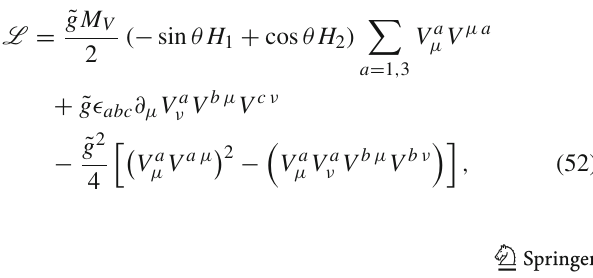
Fig. 16 Model points (red), in the [ M χ ible Higgs rate BR ( H → inv ) < 11% and complying with constraints from DM phenomenology. The model points in green are those which have, in addition, BR ( H → inv ) > 2 .